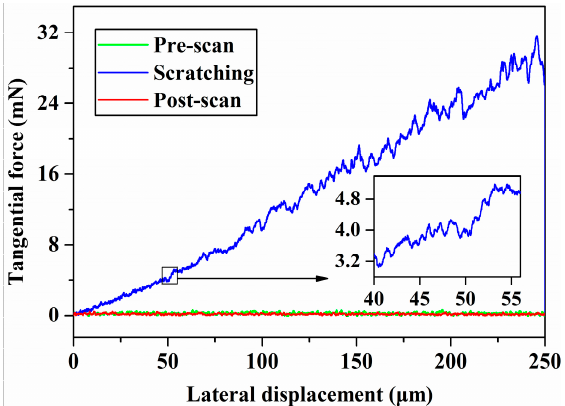
Figure 6. Tangential force as a function of lateral displacement.